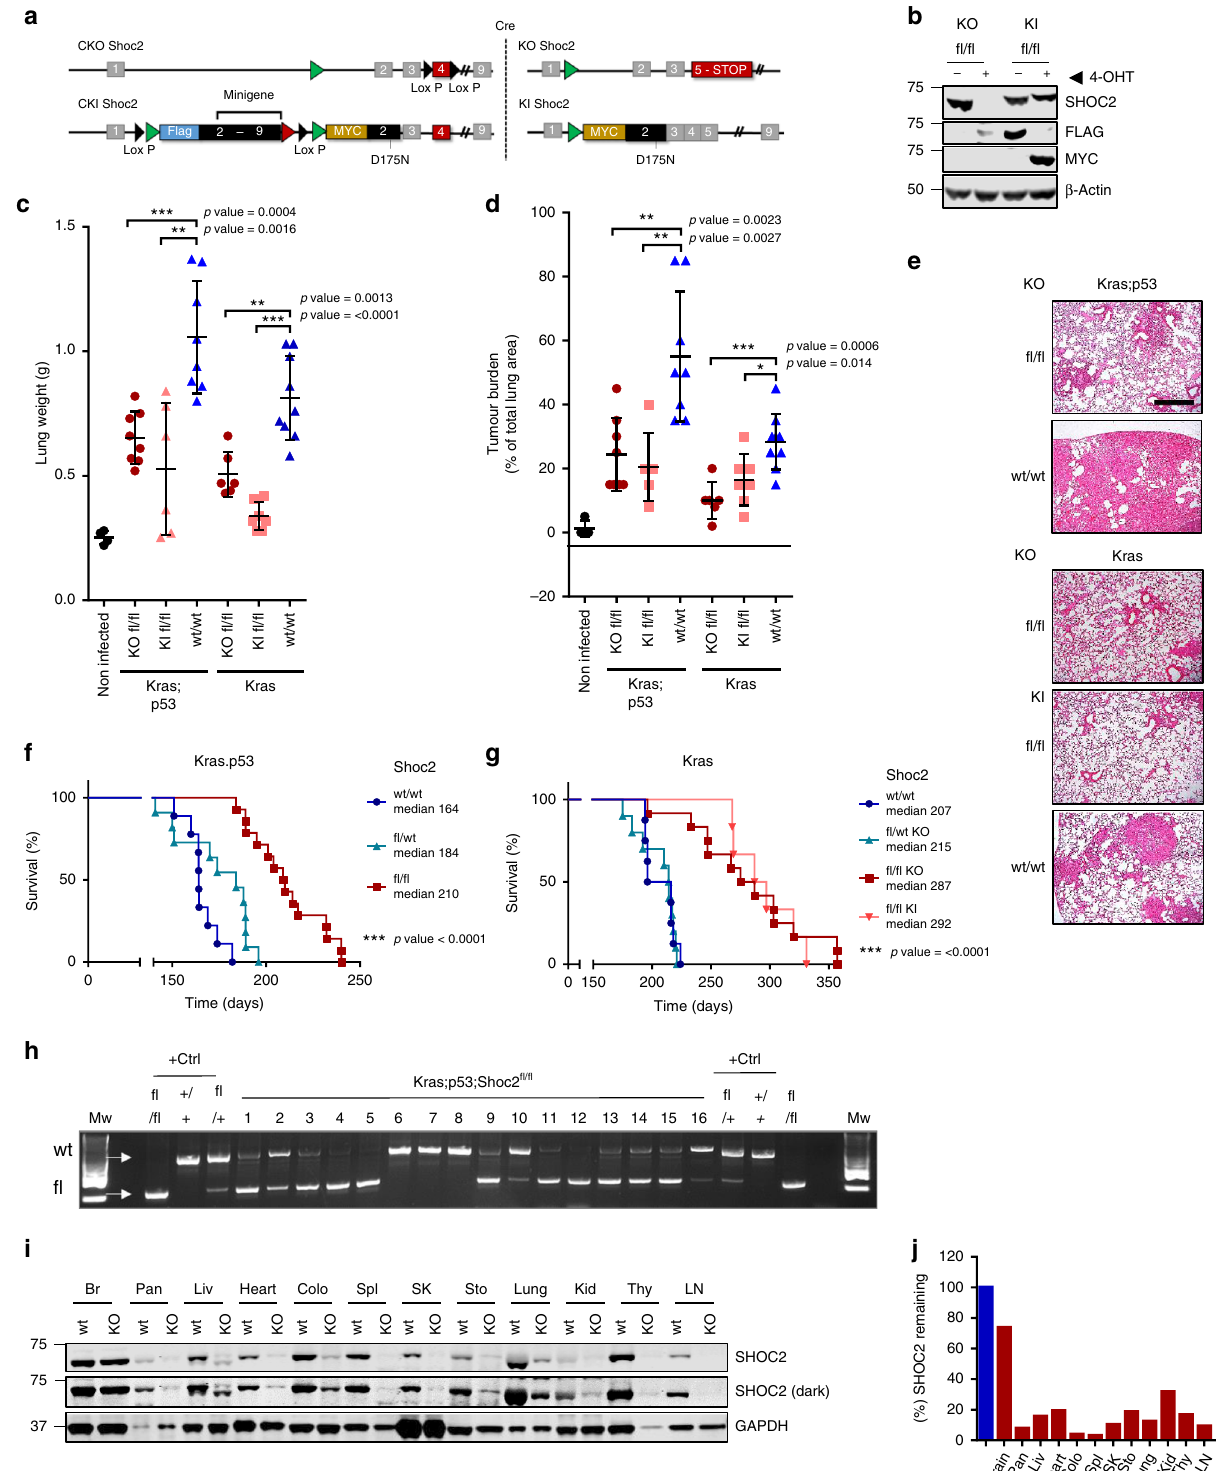
systemic SHOC2 inhibition is well tolerated in adult mice, up to 8 – 12weeks. SHOC2 is required for tumorigenic growth of RAS-mutant cell lines . To further study the role of SHOC2 in the context of lung tumorigenesis, both shRNA and CRISPR/CAS9 approaches were used to deplete SHOC2 in a panel of human NSCLC cell lines